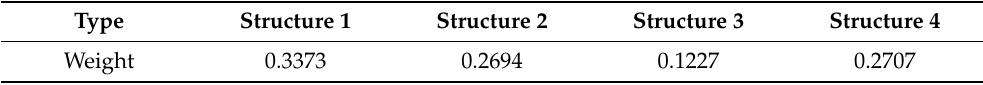
Table 8. The traditional AHP method calculates the weight